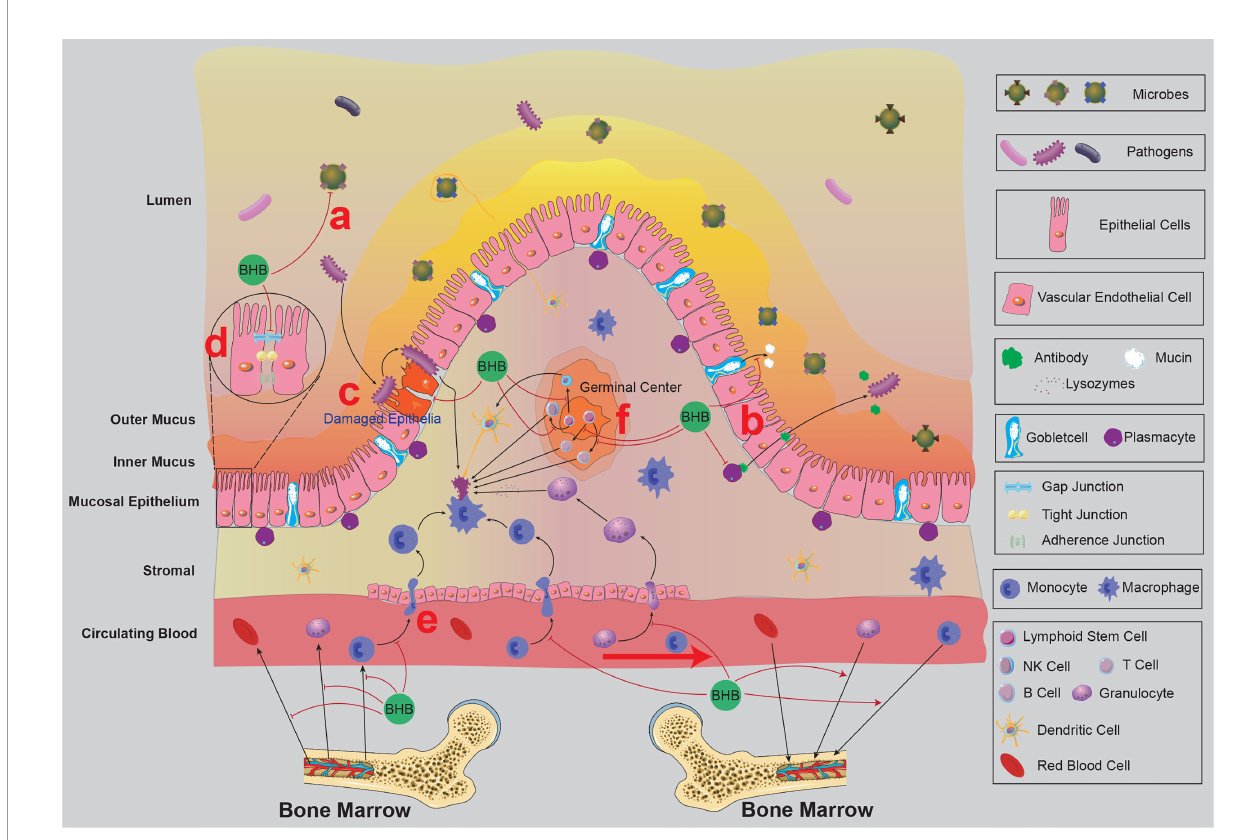
FIGURE 3 | The mucosal immunity of the intestine and the possible effects of BHB on intestinal mucosal immunity. BRC and circulating immune cells from bone marrow circulate in the blood and lymphatic system and then return to the bone marrow. BHB was found to accelerate the homing process of circulating naïve B cells, decrease the expression of CXCL13 (a chemokine that recruits naïve B cells) in the intestinal vascular endothelial cells and stromal cells, and increase the expression of adhesion proteins between vascular endothelial cells, indicating BHB might reduce the chance of circulating immune cells in fi ltrating into the intestinal mucosa. The germinal centre in the intestine tissue contains multiple kinds of follicular lymphocytes, which are released into the stromal participating in the immune defence process. BHB was found to inhibit the proliferation and differentiation of primary follicular lymphocytes, indicating BHB might reduce the number of follicular lymphocytes in the stromal. There are massive microbes on the surface of the small intestinal mucosa, which prevents the colonization of pathogens (Microbiota Barrier). BHB was found to inhibit the growth of Bi fi dobacterium and Lactobacillus in the intestine and alter the micro fl ora community of the nasopharynx, indicating BHB affects the microbiota barrier of mucosal. Covering the surface of mucosal epithelium, a layer of mucus consists of kinds of chemical components (Chemical Barrier), including mucins secreted by goblet cells, antibacterial peptides secreted by epithelial types of cells, and sIgA secreted by plasma cells, et al. BHB was found to affect the thickness and viscosity of the mucosal layer, indicating BHB might affect the secretory function of these secretory cells. The mucosal epithelial cells are woven into a dense network by tight junctions and intermediate junctions, including occlaudin, claudin, E-cadherin, Ep-CAM, et al. This network prevents pathogens from invading the mucosal tissue and resulting in infection (Physical Barrier). BHB affects the expression of adhesion proteins between vascular endothelial cells, indicating that it might also affect the physical barrier of mucosal epithelium. Macrophages, DCs and other immune cells play important roles in recognizing and eliminating the invaded pathogens. BHB was found to decrease the pro-in fl ammatory activities of granulocytes and macrophages, indicating that BHB might also affect the activities of immune cells in the infected mucosal tissues. BRC, blood-red cell; BHB, b -hydroxybutyrate; sIgA, secretory